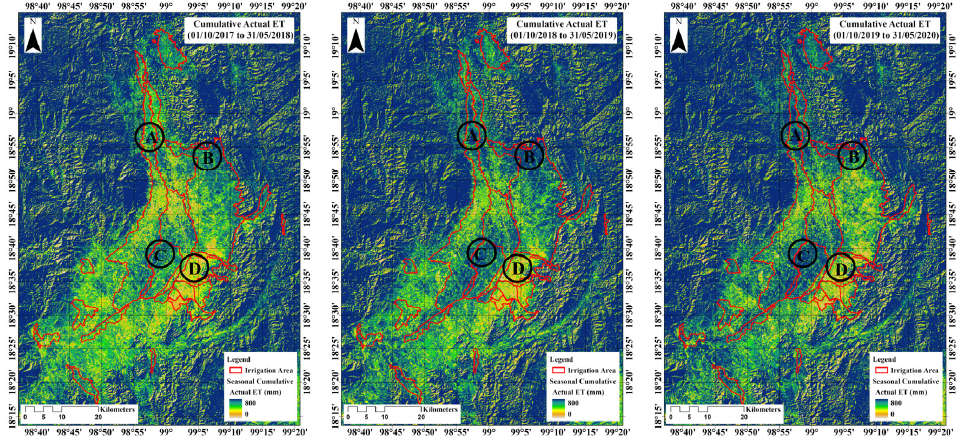
Figure 7. Spatial distribution of the seasonal actual evapotranspiration ( ET a ) in the study area located in the Chiang Mai and Lamphun provinces, which is located on the plains of the upper northern region of Thailand along the Ping River, during the dry seasons of 2018–2020. jects: Mae Tang and Mae Faek-Mae Ngat Somboon Chon (Figure 7). Area A is mainly blue-shaded area in Figure 7. Areas B and D belong to the Mae Kuang Udom Thara irri- gation project and are examples of upstream and downstream areas within the same irri- gation project. Most rice-cultivation areas with adequate water allocation are located up- stream of the irrigation project area (area B) and are shaded blue for all three years. Area